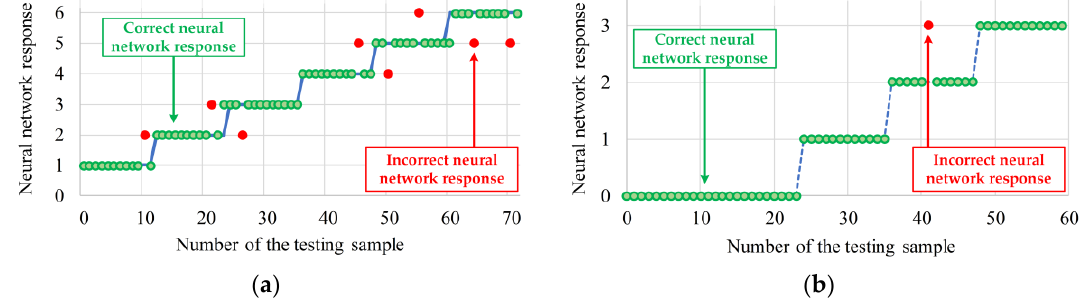
Figure 9. SOM–MLP network response: ( a ) shorted turns of stator windings; ( b ) rotor broken bars.